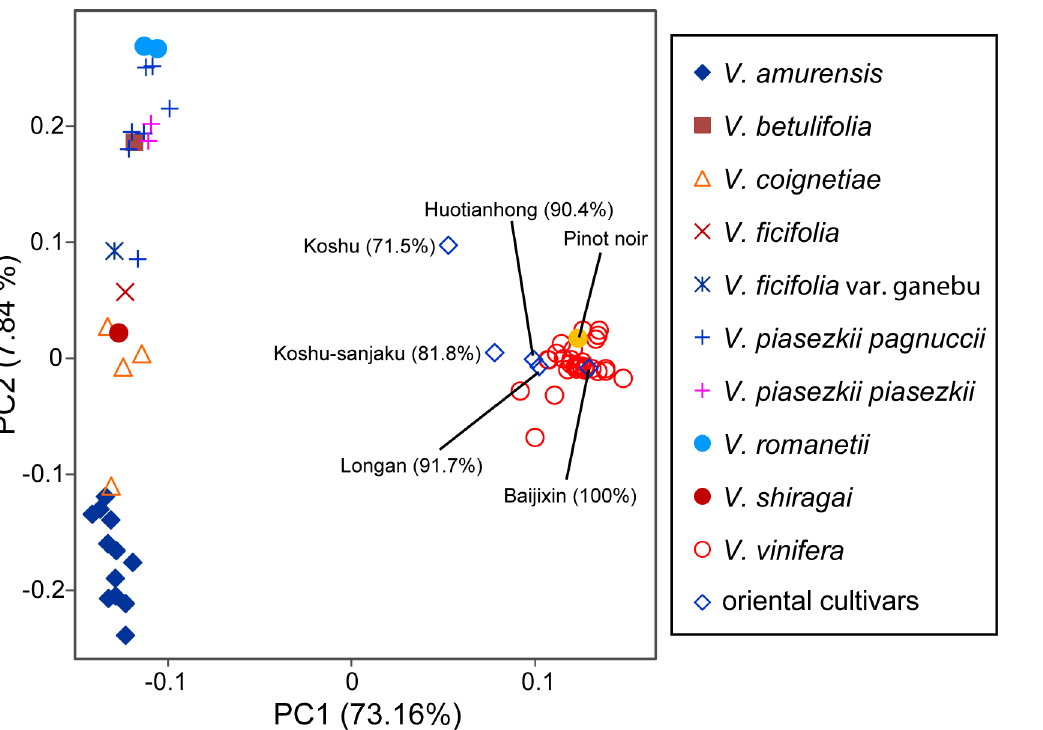
Fig 1. PCA plot of six genotyped grapevines projected on to principal components calculated from 33 accessions of East-Asian wild Vitis species and 33 cultivars of V . vinifera . Numbers in parentheses are estimated V . vinifera ancestry proportions based on PC1.